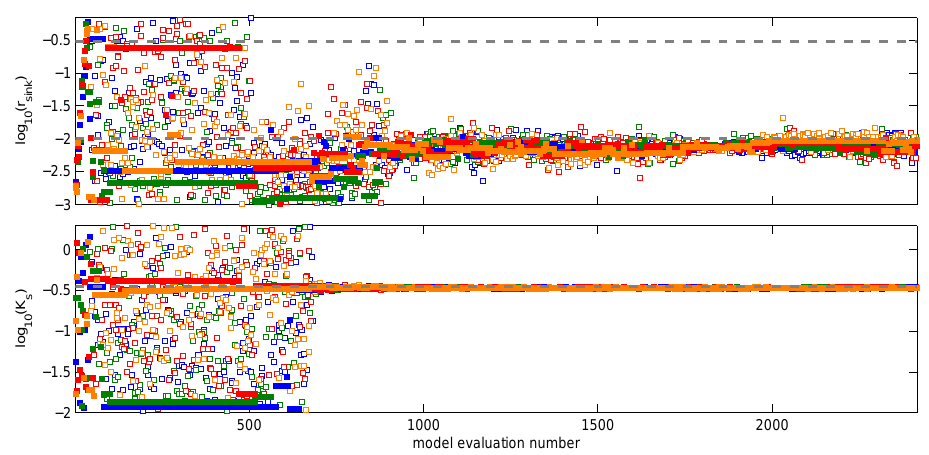
Fig. 9. SODA (reduced and perturbed data set): evolution of the parameters. Dashed lines represent value of r sink ( low ) and r sink ( high ) (upper plot) and K s (lower plot). Markov chains are color-coded; open symbols are samples that have been rejected by the Metropolis scheme, while solid colors have been accepted. Note that the vertical axes are logarithmic.